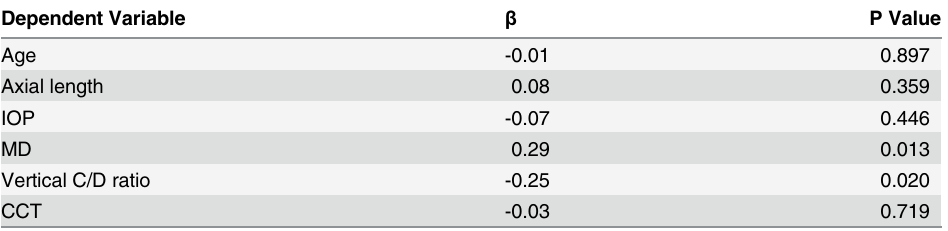
Table 2. Multiple regression analysis of independent variables affecting lamina cribrosa thickness.